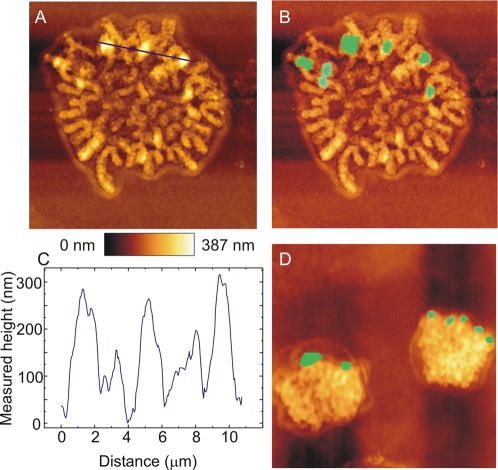
Atomic force microscopy.A. Atomic force microscopy of a CHP-212 prometaphase cell. B. Superimposition of MYCN fluorescence in situ hybridisation (FISH) signals allows localisation of DMs in the AFM image. C. Surface plot of the segment indicated by a blue line in A shows that DMs correspond to surface peaks of approximately 200 nm. D. Superimposed AFM and FISH images show peripheral location of DMs in a late telophase cell. Surface height is shown by the heat map and surface dimensions are indicated by scale bars corresponding to 2 µm in A, B and D.